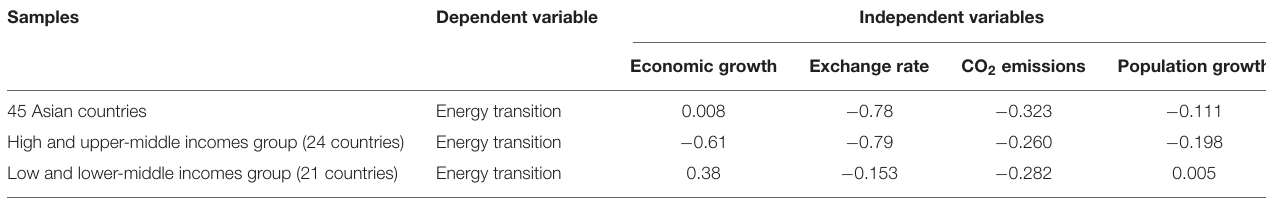
TABLE 2 | Pearson correlation results.